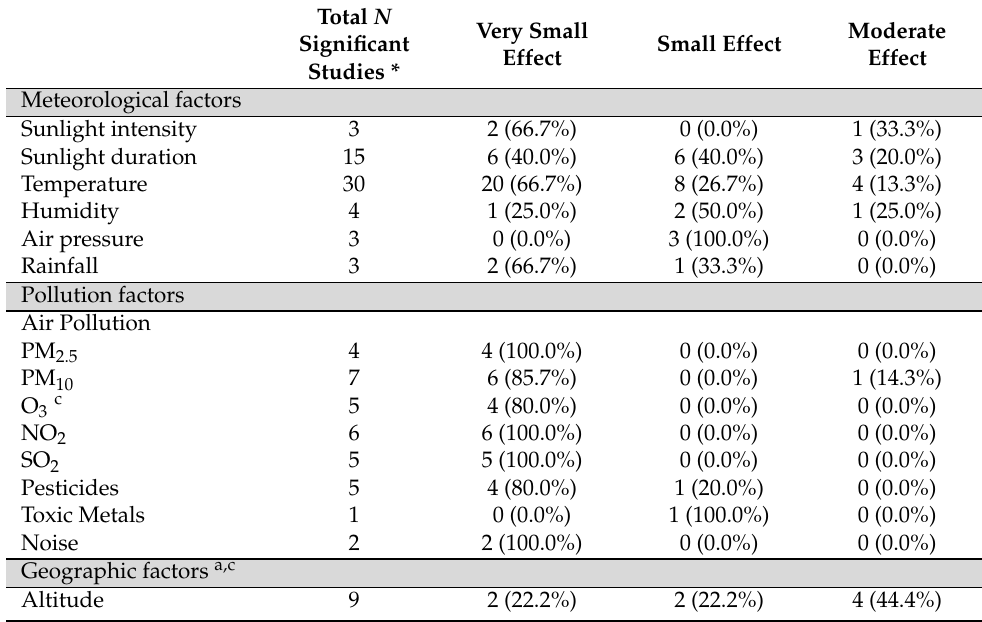
Table 4. Reported effect sizes among studies reporting a significant result.